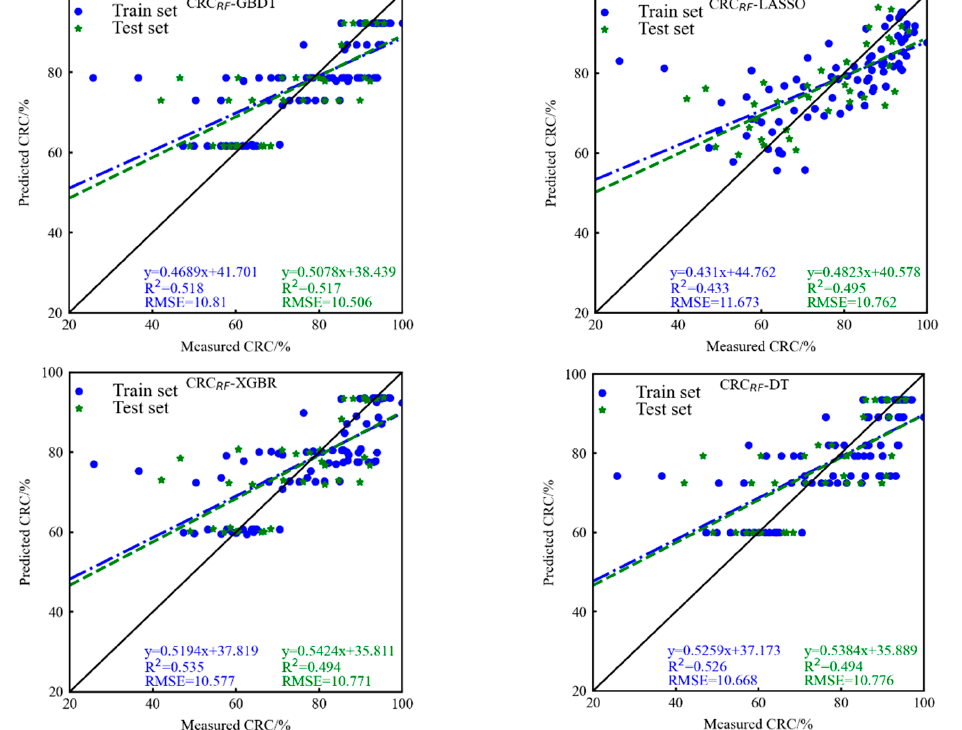
Figure 11. Regression relationship between CRC and XGBR, LASSO, GBDT and DT regression models of GF-1 data.